Question: Produce a descriptive caption suitable for publication.
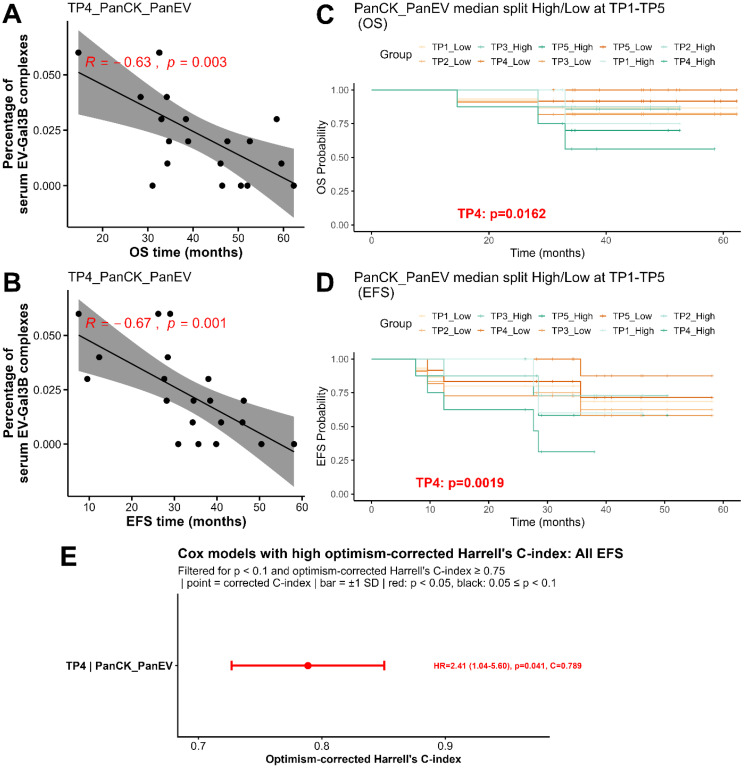
Answer: (A, B) Correlation of PanCK + /PanEV + -EXÖBead complex at TP4 with OS (p = 0.003) and EFS (p = 0.001). (C, D) Kaplan–Meier analysis of OS and EFS stratified by TP4 PanCK + /PanEV + -EXÖBead levels (OS: p = 0.0162; EFS: p = 0.0019). (E) Continuous-variable Cox regression for EFS at TP4 for PanCK + PanEV + EV-EXÖBead complex (HR per 1 SD: 2.41, 95% CI 1.04–5.60, p = 0.041, optimism-corrected C-index = 0.789); points indicate corrected C-index and bars ±1 SD from bootstrap resampling.